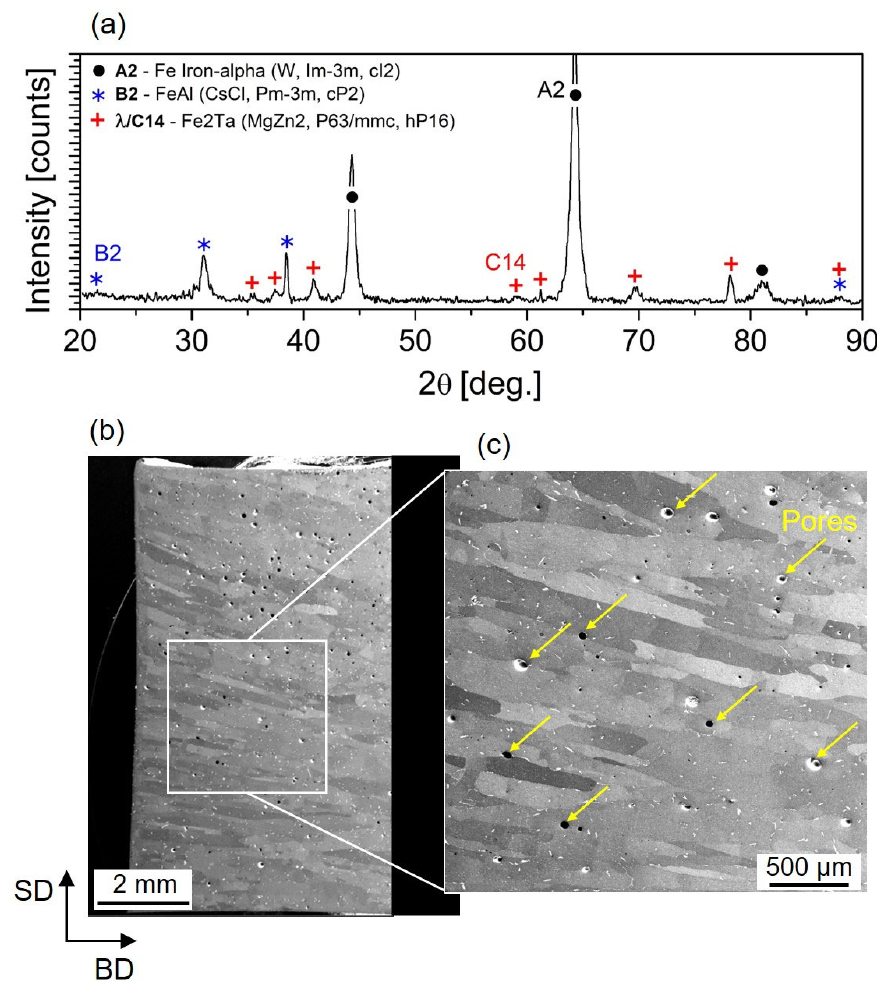
Figure 1. Room-temperature XRD pattern ( a ) and a typical BSE-SEM microstructure of the cross-section of cylindrical Fe-25Al-1.5Ta specimens produced by LPBF ( b , c ). The arrows in a higher magnification image in ( c ) indicate a few pores. BD and SD refer to the building and scanning direction. The small white-contrast regions are (Fe, Al) 2 Ta C14 Laves phase precipitates formed along the matrix grain boundaries and within the grains. The sample was printed using P = 250 W and v s = 1000